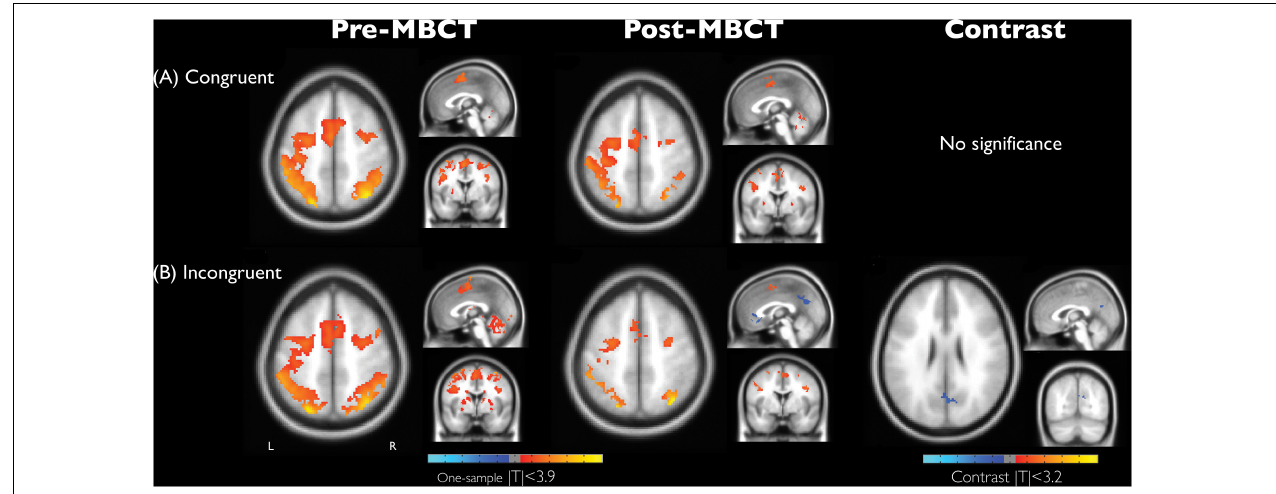
FIGURE 1 | Brain activation maps associated with condition effect of (A) congruency and (B) incongruency and its difference and the intervention effect (before and after MBCT) in the numerical Stroop task on grief bereavement (AlphaSim corrected p < 0.05). Anatomical images were shown with coordinate location = [0, 0, 52] for one-sample t maps and [–2, –70, 26] for contrast maps. L, the left hemisphere.